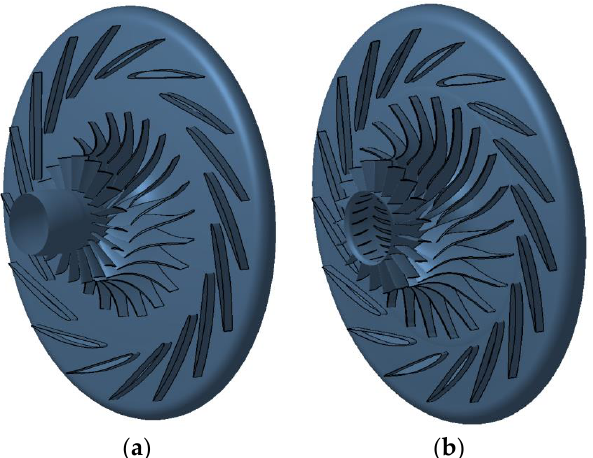
Figure 3. Structure of an MW-level gas turbine.